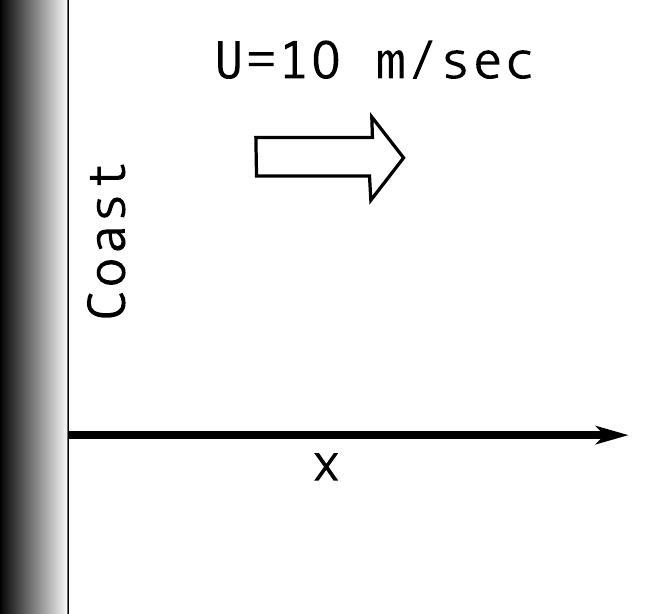
Figure 1. Limited fetch problem geometry. Constant wind of 10 m/s is blowing orthogonally to the